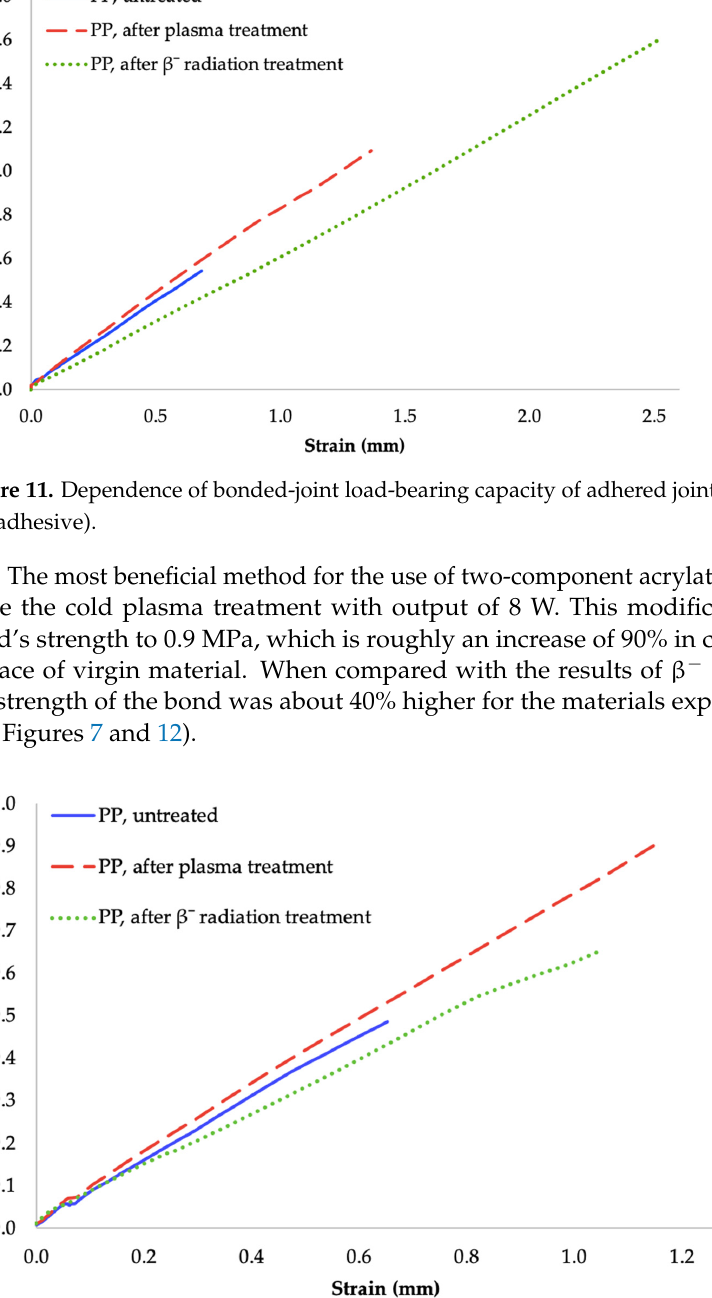
Figure 10. SEM micrographs of ( a ) PP, untreated, ( b ) PP, after β ¯ radiation treatment, and ( c ) PP, after plasma treatment.